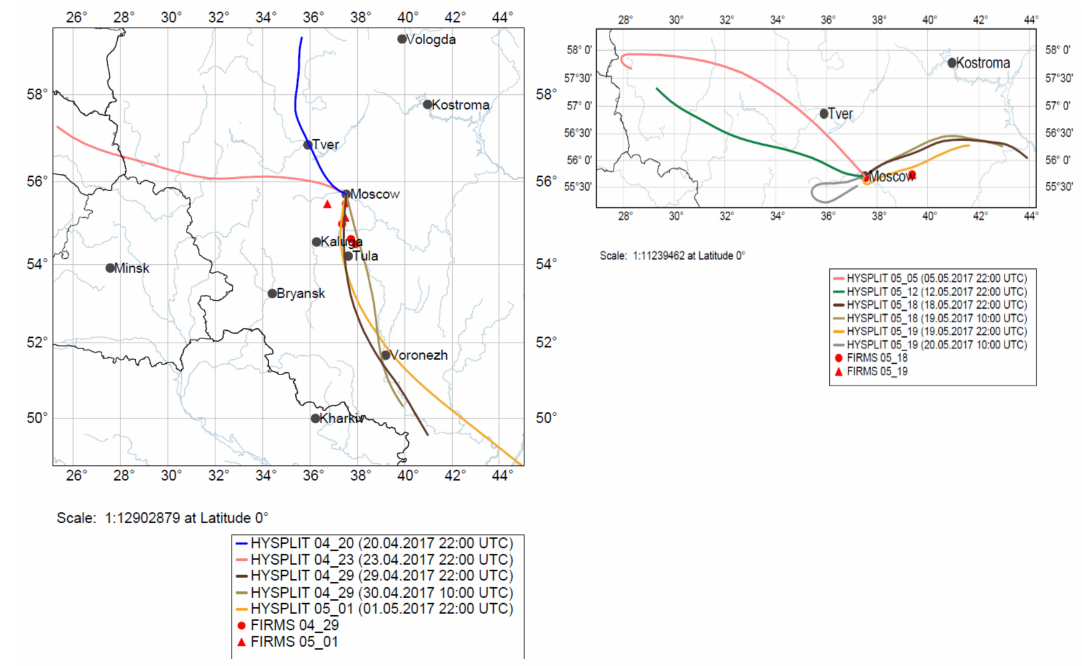
Figure 4. Two-day back air mass transportation from the HYSPLIT model in the days of the BB-a ff ected period ( left ) and FF period ( right ), 500 m A.S.L. Fires observed by FIRMS in indicated days are marked by circles and